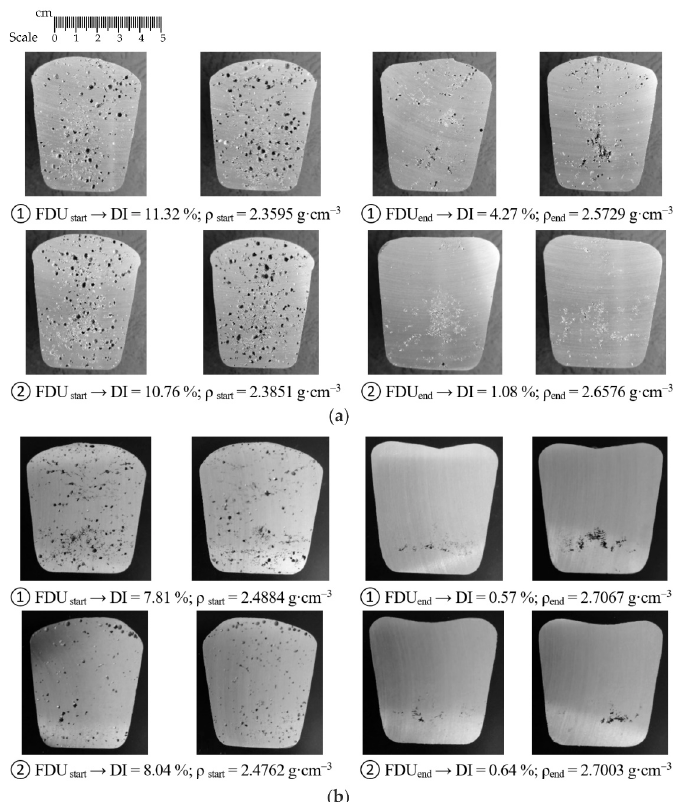
Figure 6. Sections of samples taken for gasification assessment for rotor A: ( a ) wear 0% (series 1/VT); ( b ) wear 75% (series 4 /VT).